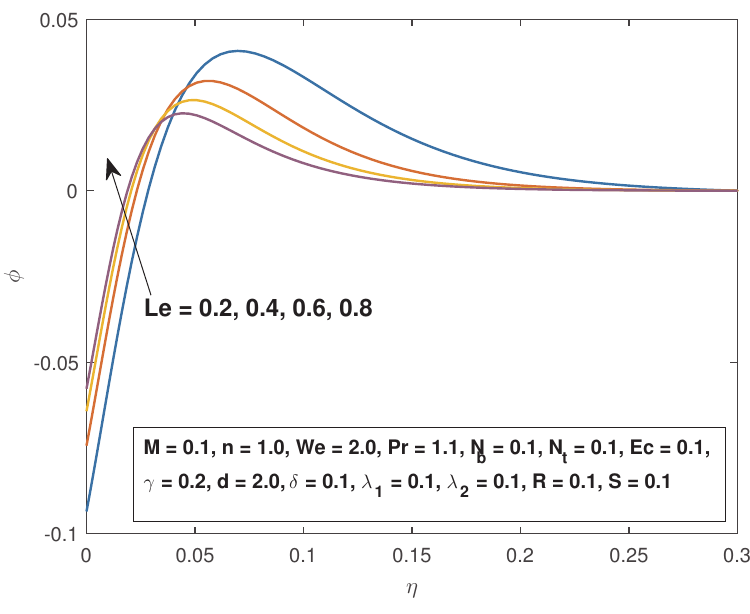
Figure 16. Influence of Le on the fluid concentration.